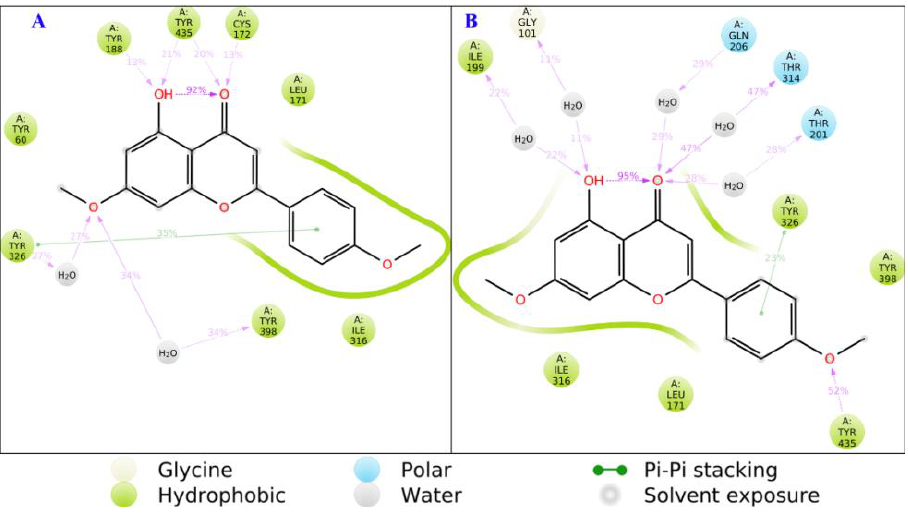
Figure 4. The 2D protein – ligand contacts for pose 1 ( A ) and pose 2 ( B ) for acacetin 7- O -methyl ether.